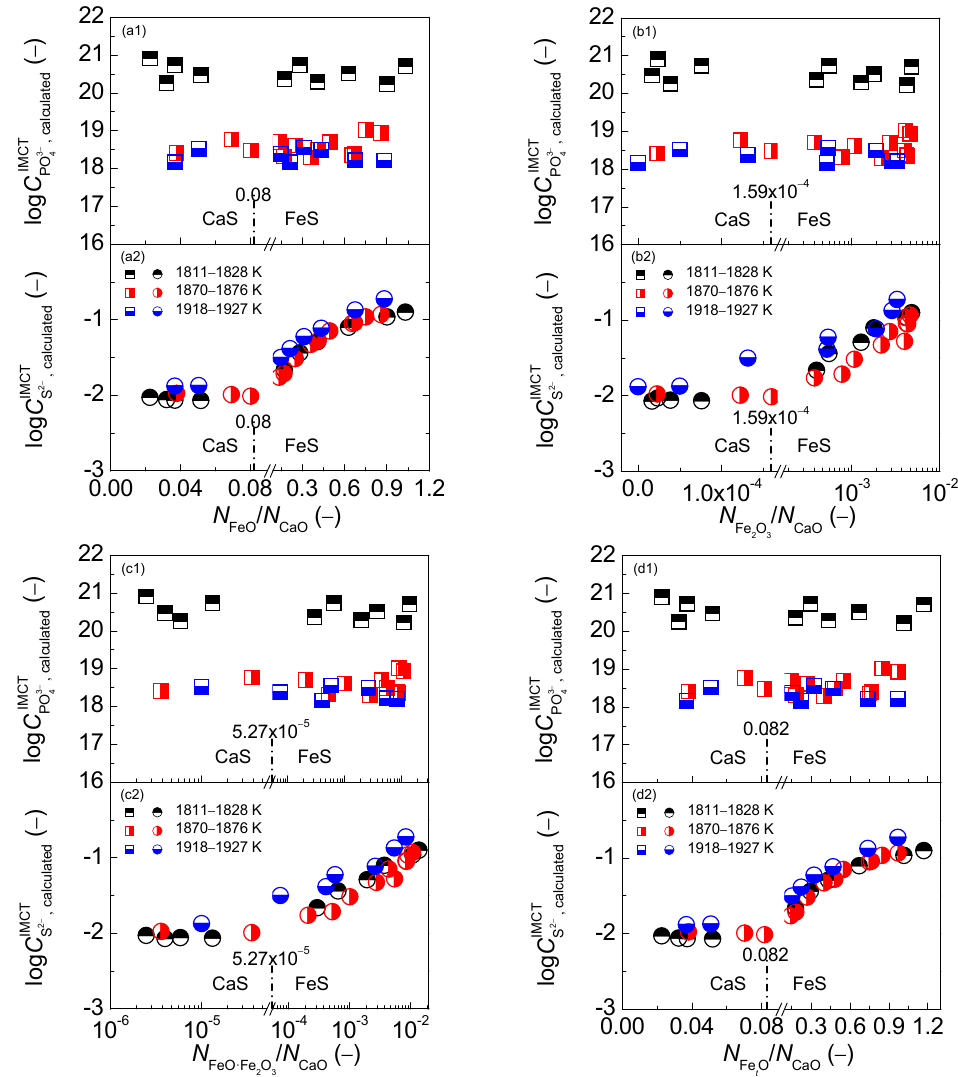
Figure 12. Relationship of mass action concentration ratio N FeO / N CaO ( a ) or N Fe ( b ) or N FeO · Fe / N CaO ( c ) or N Fe / N CaO ( d ) against the calculated [3] phosphate capacity log C IMCT by the IMCT– C model in the first layer or calculated [5] sulfide capacity log C IMCT by the IMCT– C model in the second layer for CaO–FeO–Fe 2 O 3 –Al 2 O 3 –P 2 O 5 slags equilibrated with liquid iron over a temperature range of 1811 to 1927 K (1538 to 1654 °C), respectively.